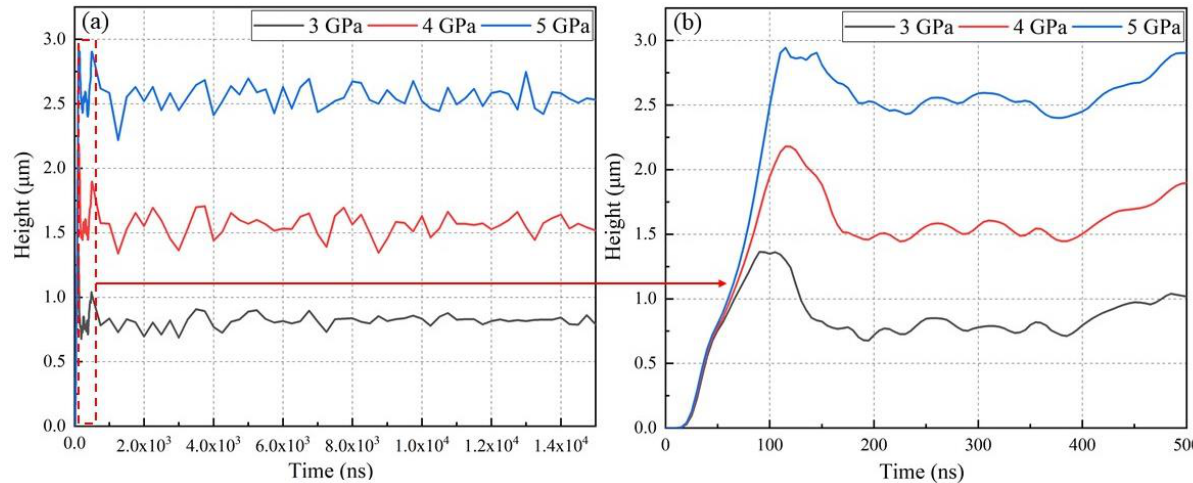
Figure 5. Evolution of embossment height at different peak pressures with time, where ( b ) shows in detail the first 500 ns of ( a ).